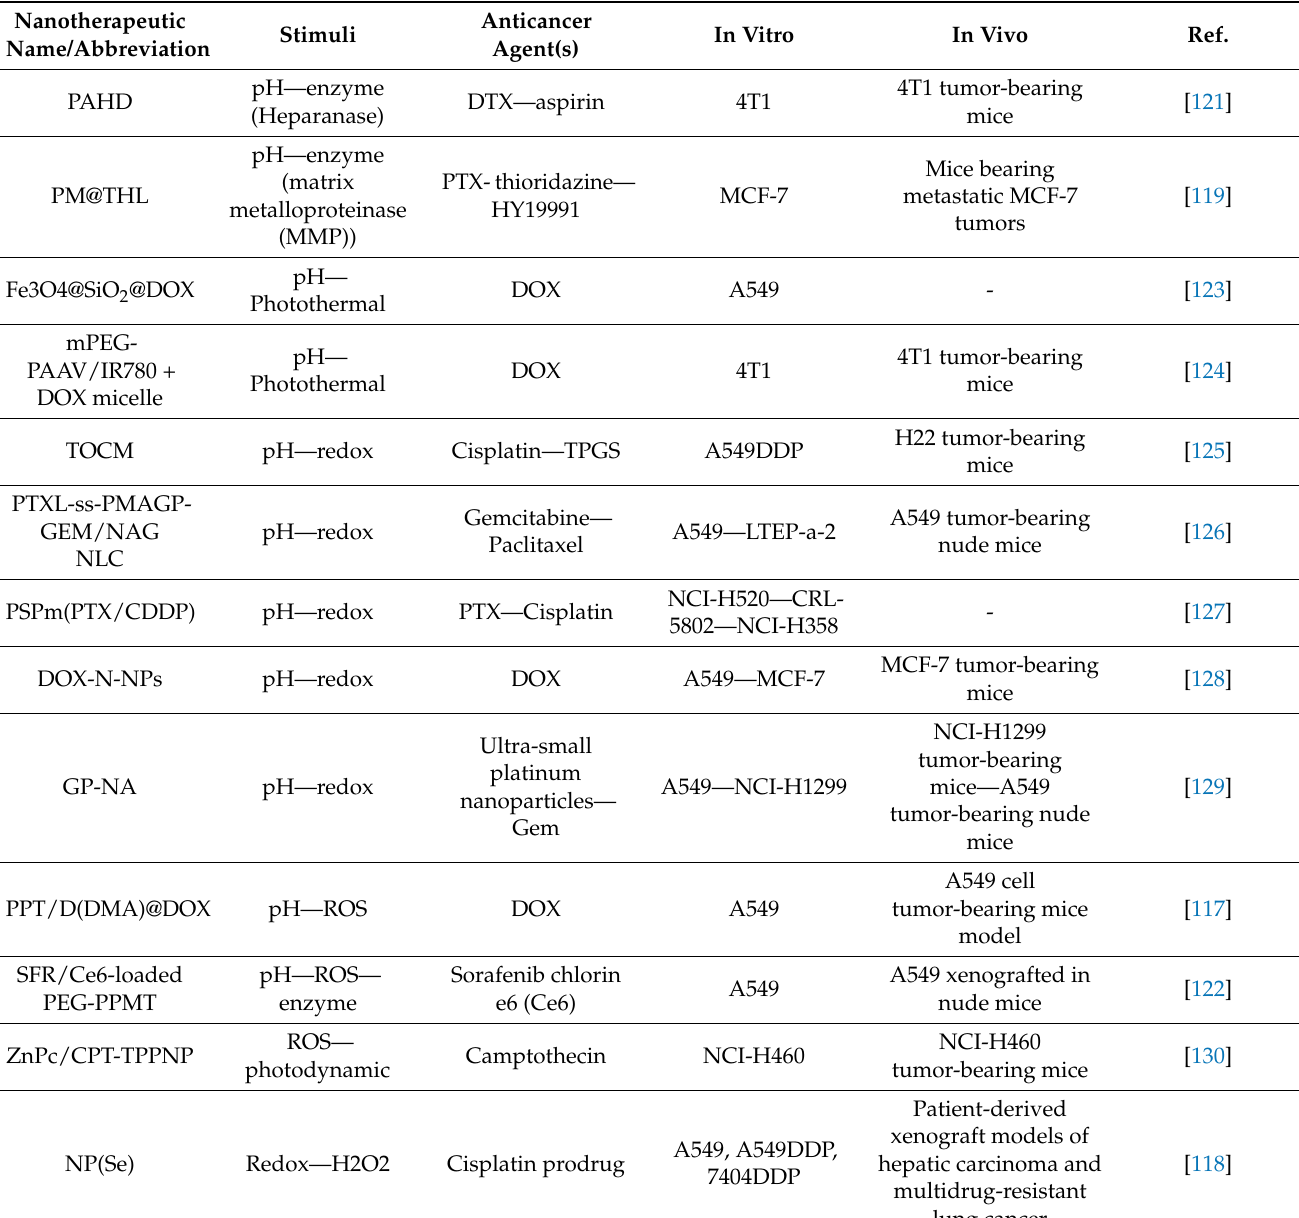
Table 2. Recent smart nanotherapeutics developed for lung cancer that are responsive to two or more stimuli.